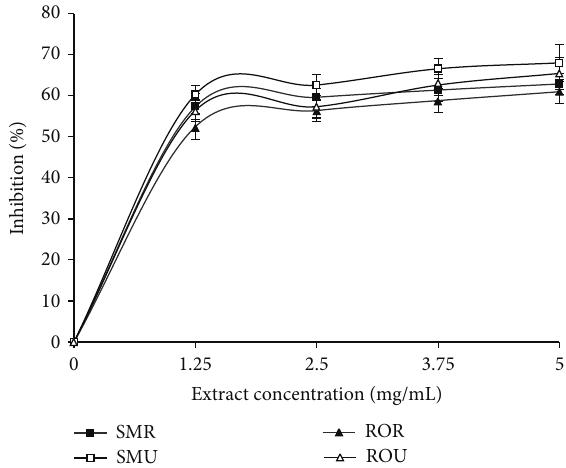
Figure 4: Inhibition of acetylcholinesterase by aqueous extract of Capsicum spp. SMU: Capsicum annuum var. accuminatum (unripe). SMR: Capsicum annuum var. accuminatum (ripe). ROU: Capsicum chinense (unripe). ROR: Capsicum chinense (ripe).